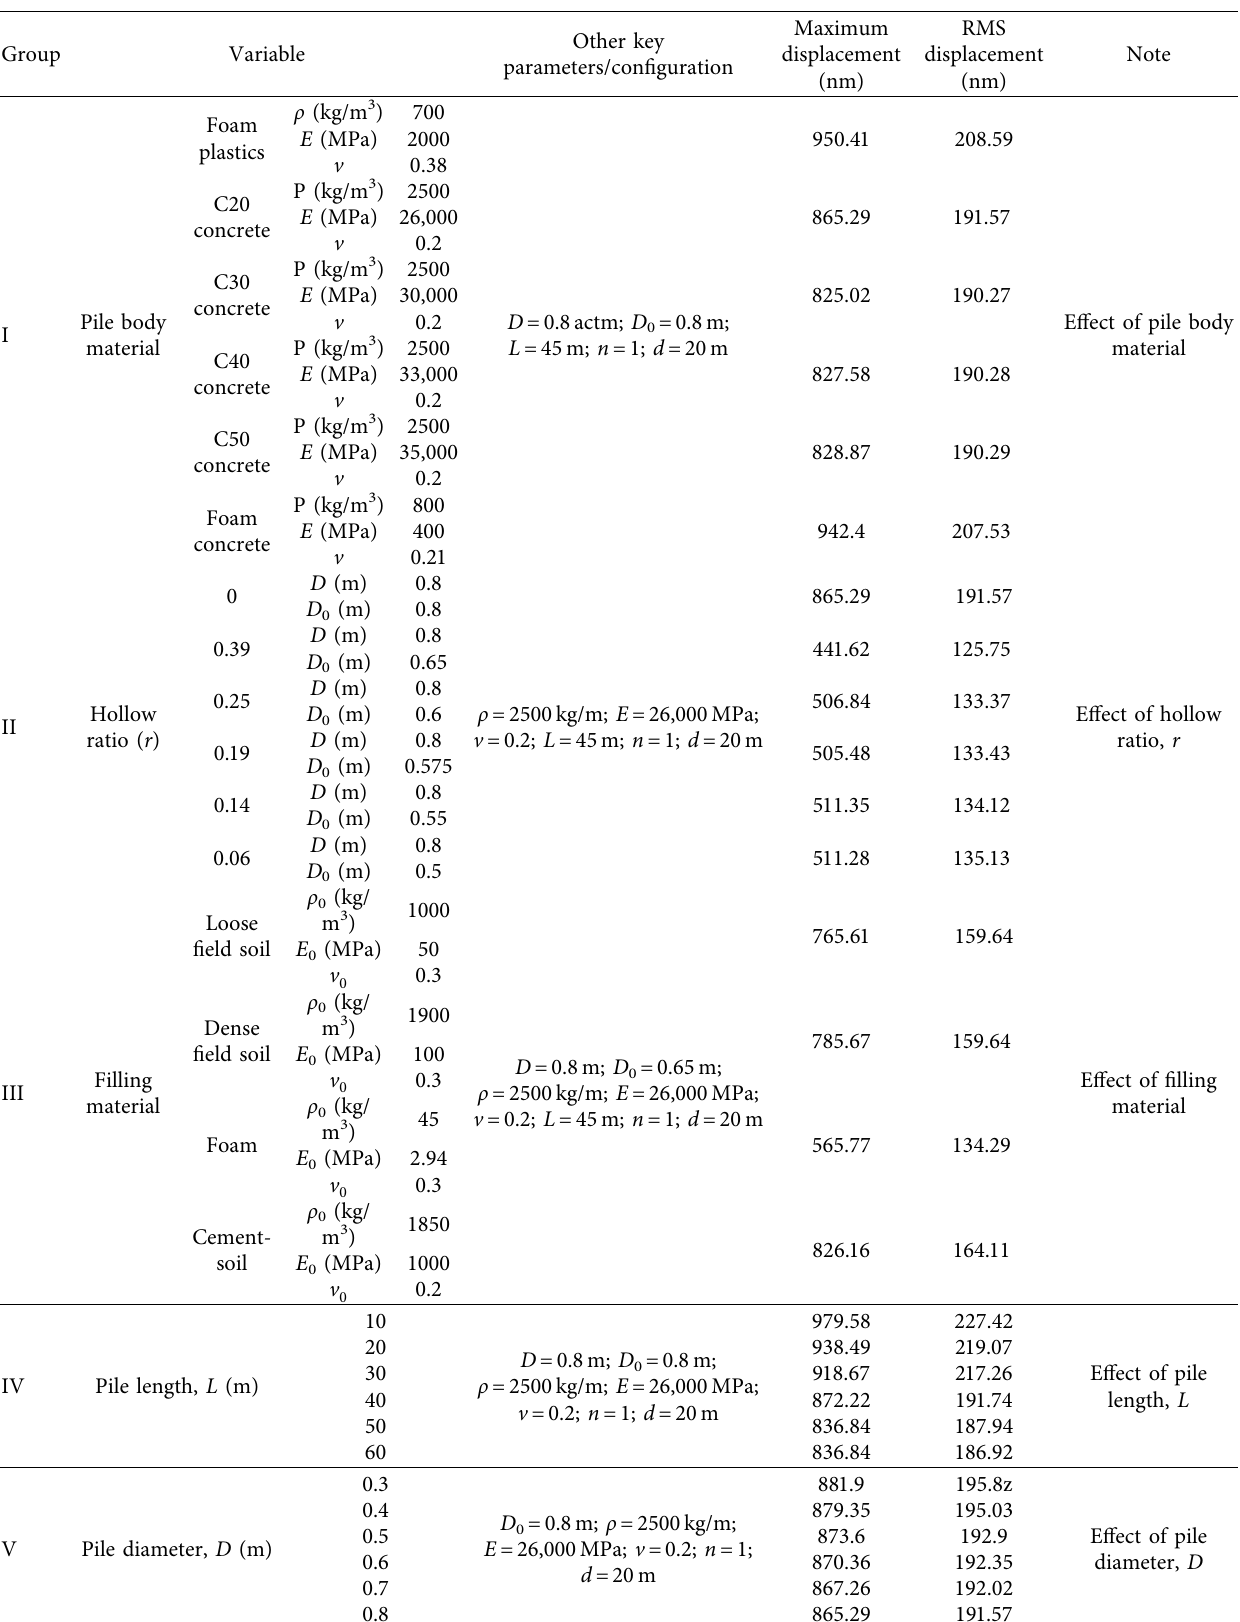
Table 6: Summary of parametric